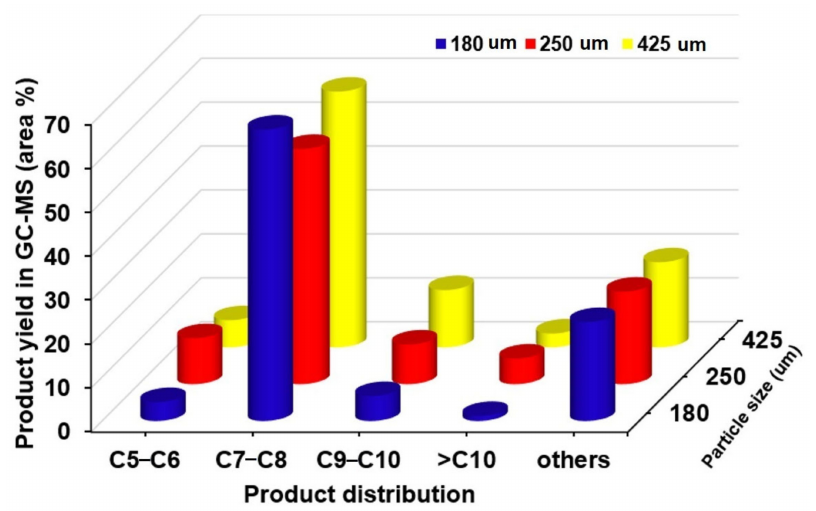
Figure 9. The effect of the biomass particle size on the HVC liquid fraction yield after 6 h at 300 ◦ C under 2 bars initial N 2 pressure with 5 wt.% commercial NiAl with respect to biomass amount, 2 g biomass, and methanol solvent.